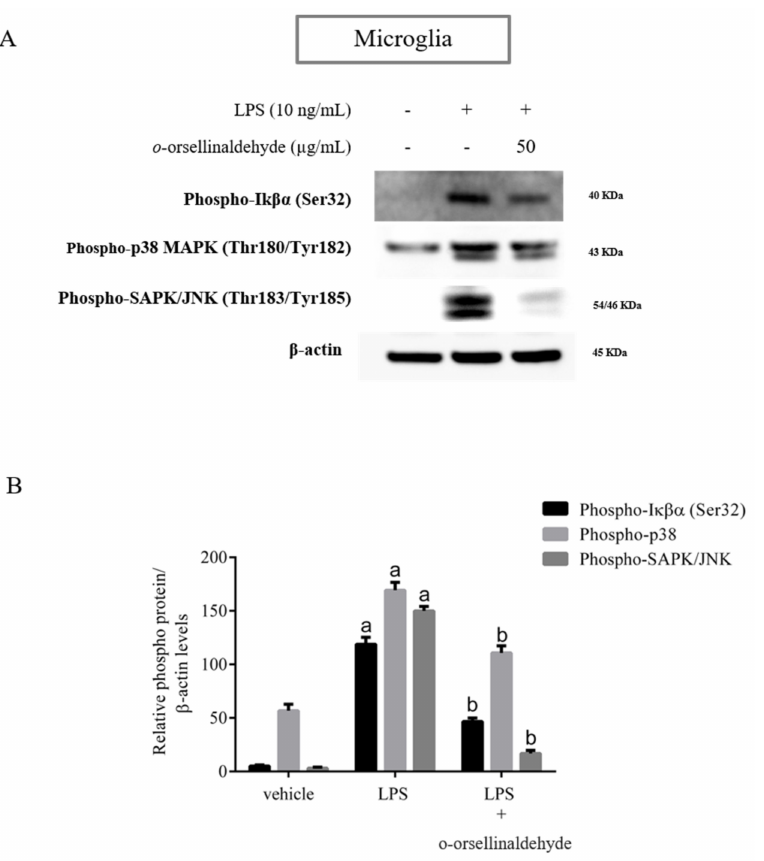
Figure 6. o -Orsellinaldehyde abrogates microglial LPS-induced NF κβ and MAPK activation. Cells were incubated with 50 µ g/mL of o -orsellinaldehyde for 30 min before treatment, and with LPS (10 ng/mL) for 45 min. The cell pellet was collected for phosphorylation measurement by Western blot. ( A ) Representative image of IK βα , p38 and SAPK/JNK phosphorylation levels by Western blotting in microglia. ( B ) Densitometry plot of Western blots carried out in microglia. Results are shown as the mean ± SD of four independent experiments. Statistically significant differences ( p ≤ 0.05) of LPS compared to the control condition are expressed as an “a”. Statistically significant differences ( p ≤ 0.05) between LPS conditions are expressed with a